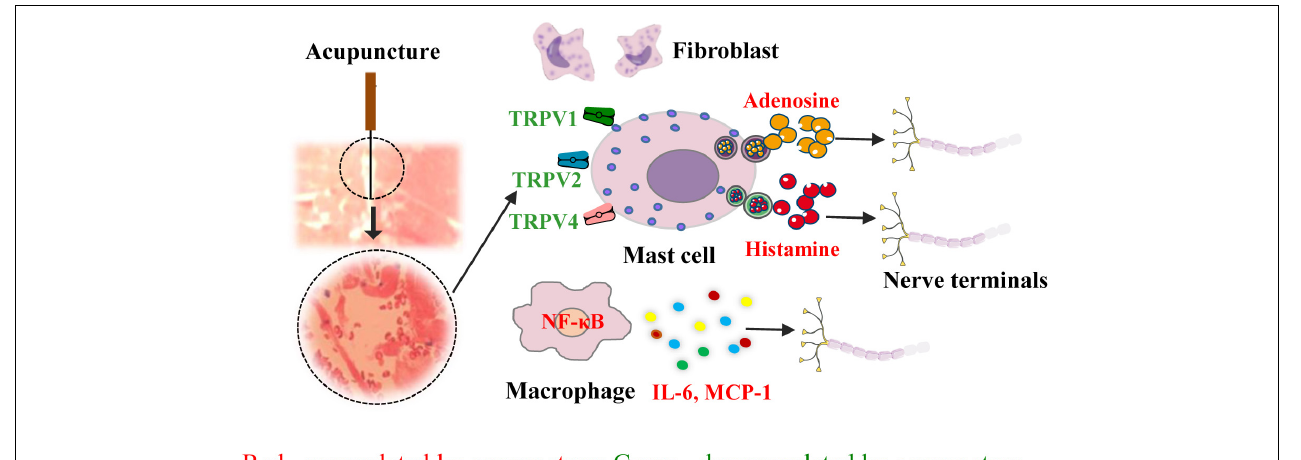
FIGURE 2 | Role of neuroimmune crosstalk at the acupoint in mediating the anti-inflammatory and analgesic effects of acupuncture on inflammatory pain. The names of immune factors are presented in red and green, respectively. The factors in red are up-regulated by acupuncture, while those in green are down-regulated by acupuncture. NF- κ B, nuclear factor kappa-B; TRPV1/2/4, transient receptor potential ion channel vanilloid 1/2/4; MCP-1, monocyte chemoattractant protein-1; IL-16, interleukin- 6.